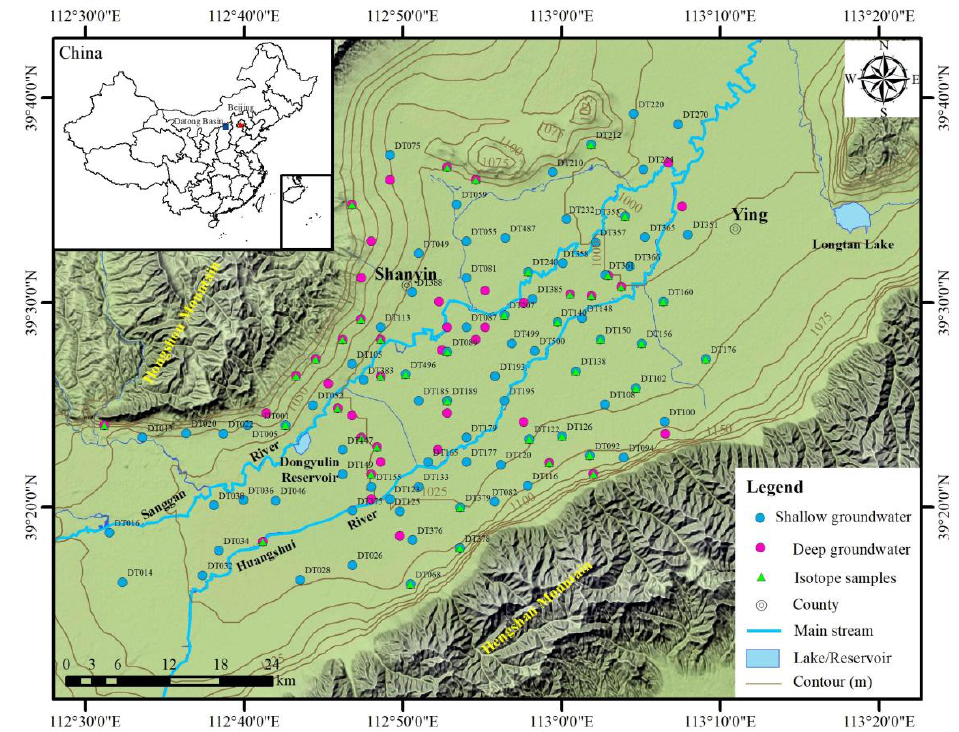
Figure 1. Topography and sampling sites of the study